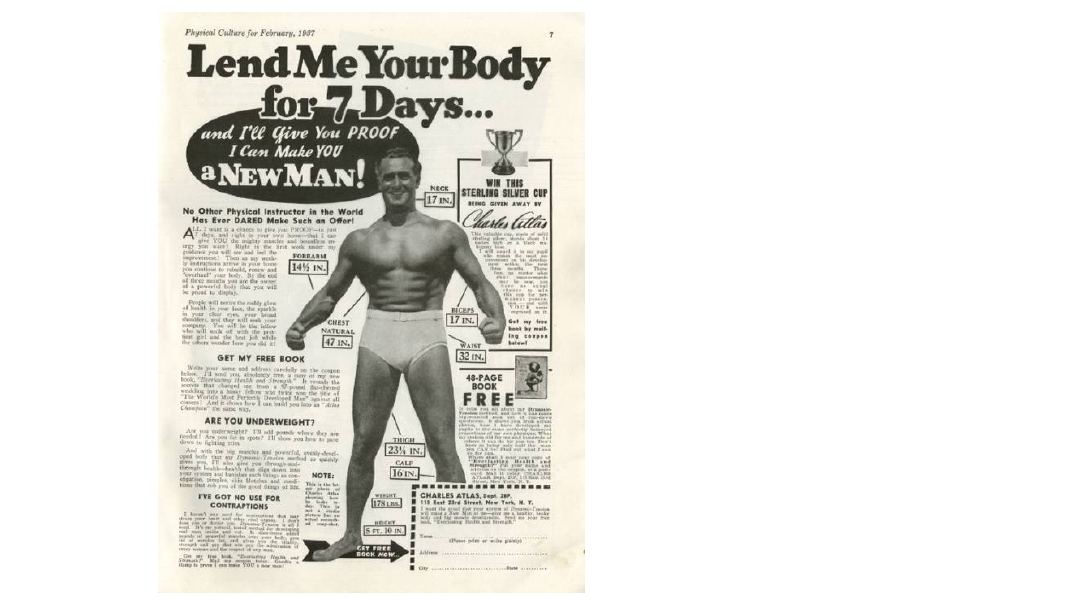
Figure 7. Charles Atlas, “Lend Me Your Body for 7 Days,” Physical Culture vol. 77 (2), 1937, p. 10. https://dmr.bsu.edu/digital/collection/PhyCul/id/13386 (accessed on 27 August 2021). Source: Ball State University Archives and Special Collections.